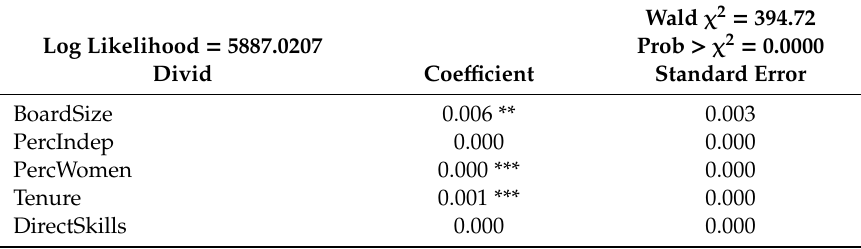
Table 3. Results of the regression based on a Tobit model for all corporations. The